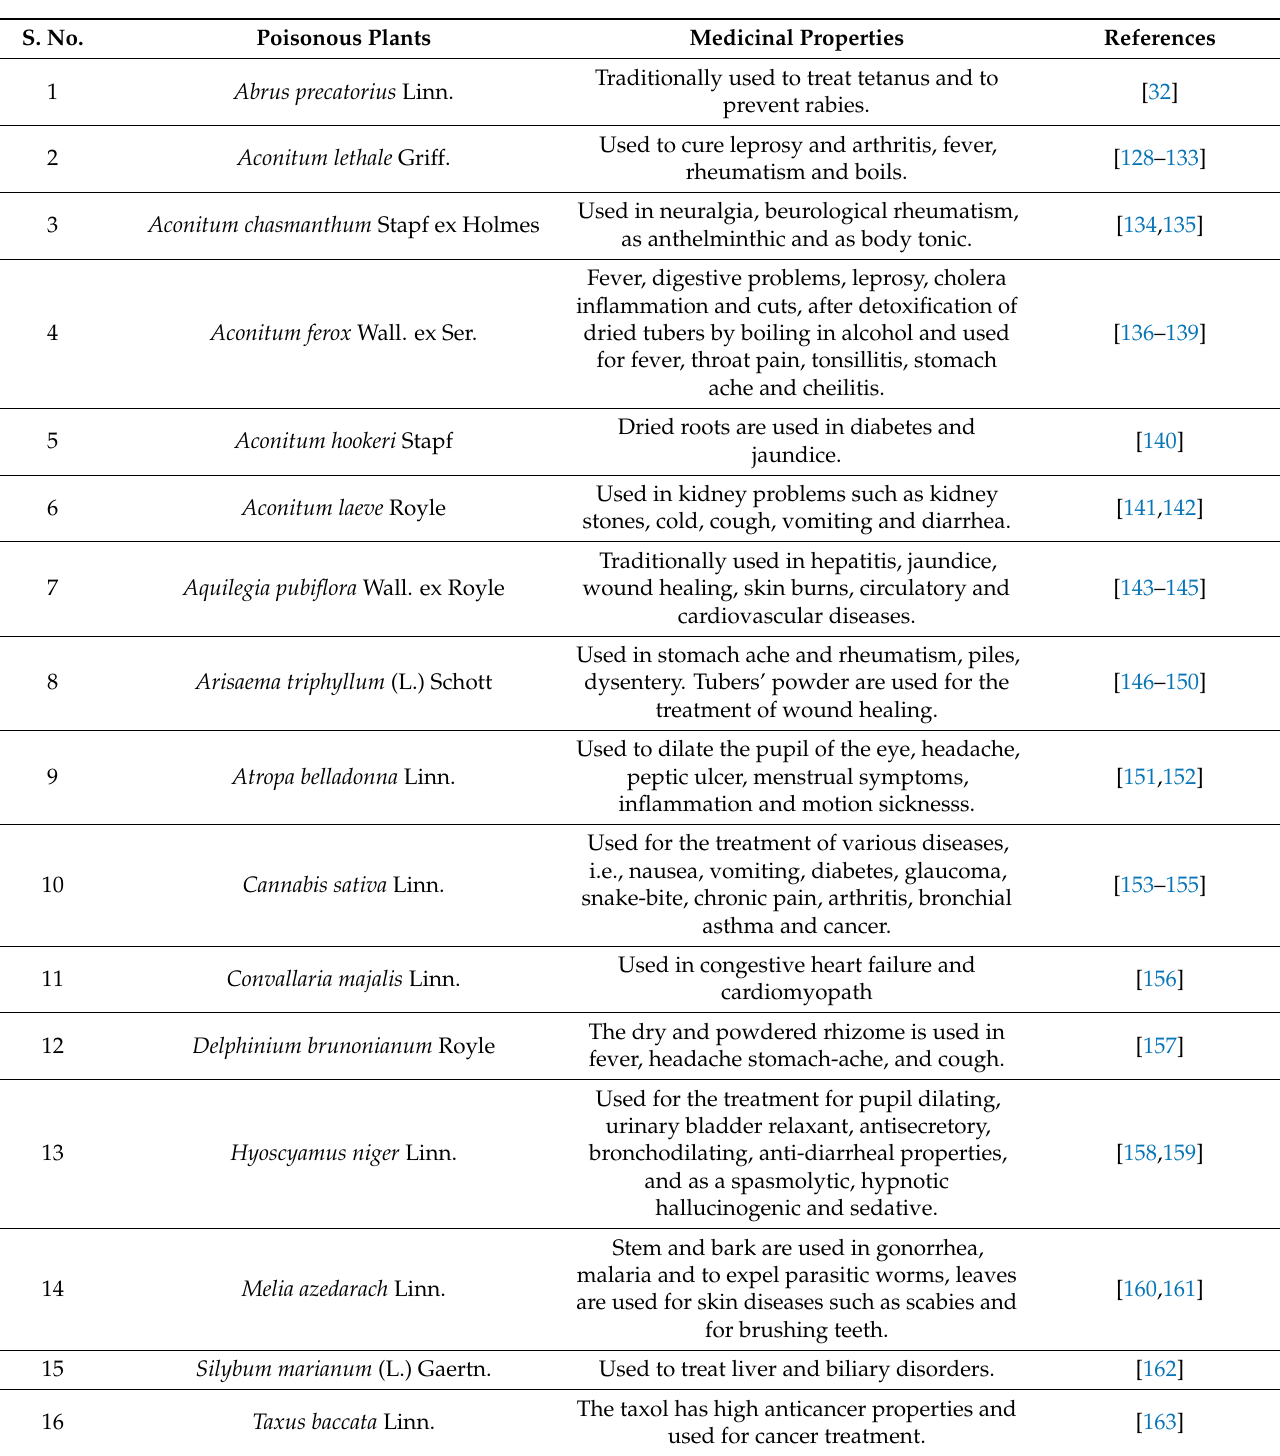
Table 2. Medicinal uses of some poisonous plants (Figure